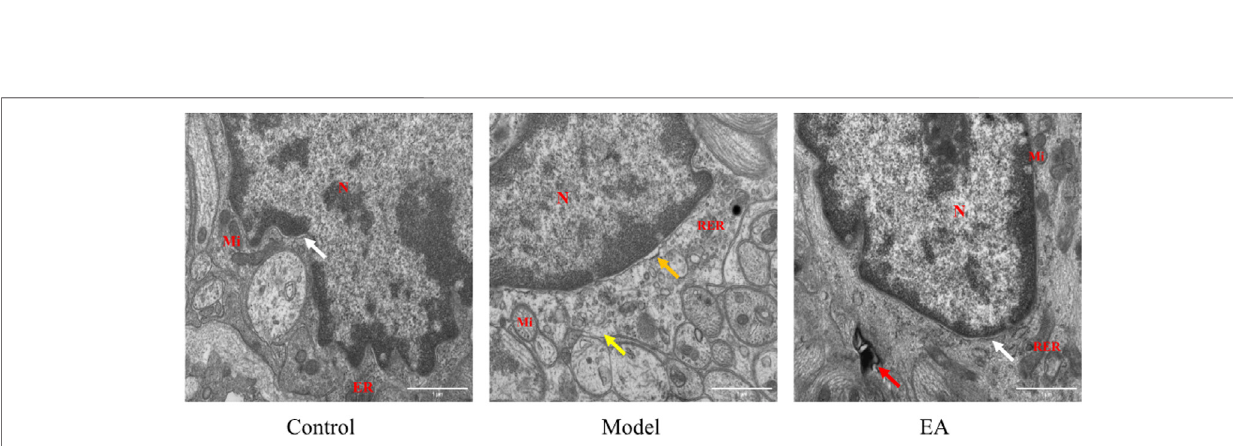
FIGURE4| MorphologyofEGCinthemusclelayerunderTEM(×30,000).N:nucleus,Mi:mitochondrion,RER:roughendoplasmicreticulum.Inthemusclelayer,a widened perinuclear space ( ) and ribosome loss ( ) were observed in the model group, mild autophagy ( ) was observed in the EA group, and a normal perinuclear space ( ) was observed both in the control and EA groups. Scale bar = 1 μ m, n = 3.